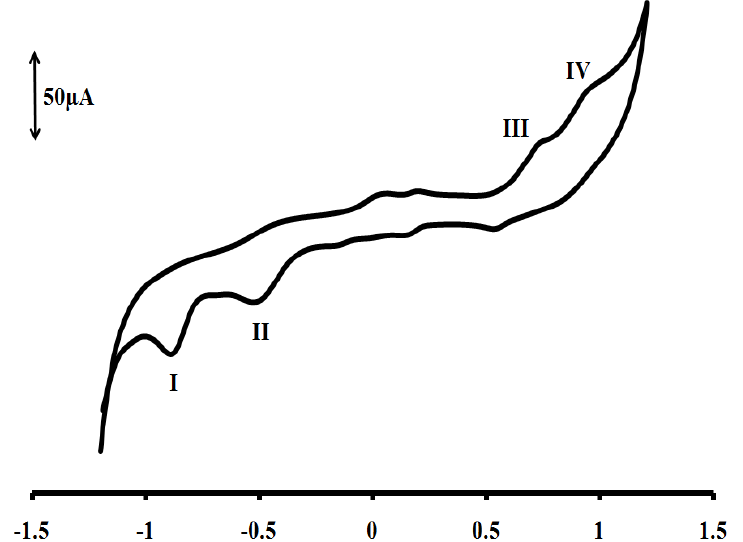
L (NCS) ] complex at 1 × 10 − 3 M in freshly 1 2 2 supporting electrolyte. Step potential = 5 mV, 4